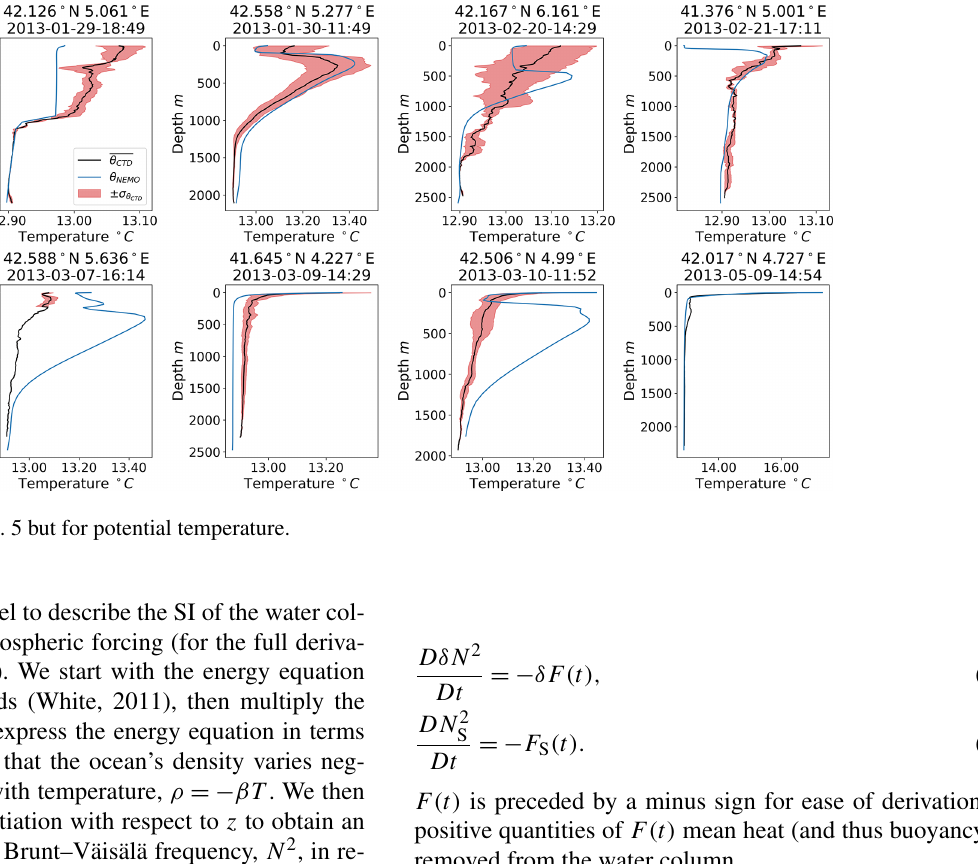
, is marked in red and is CTD